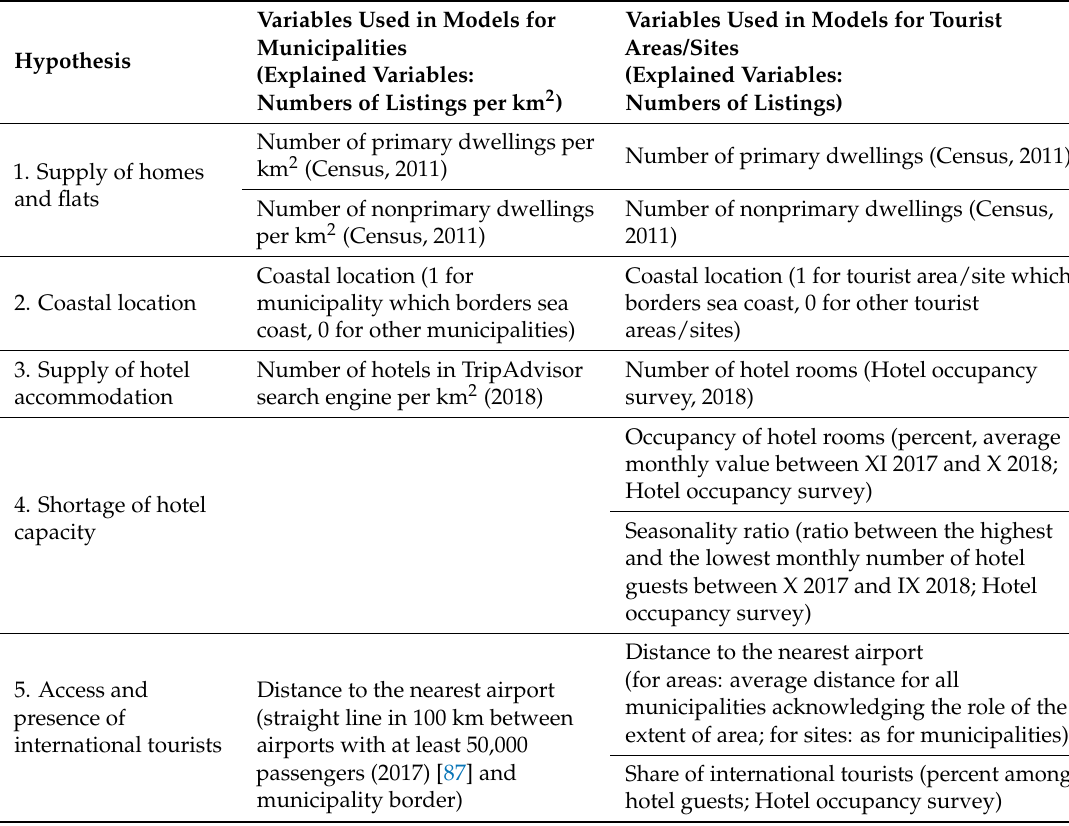
Table 1. Explaining variables used in regression